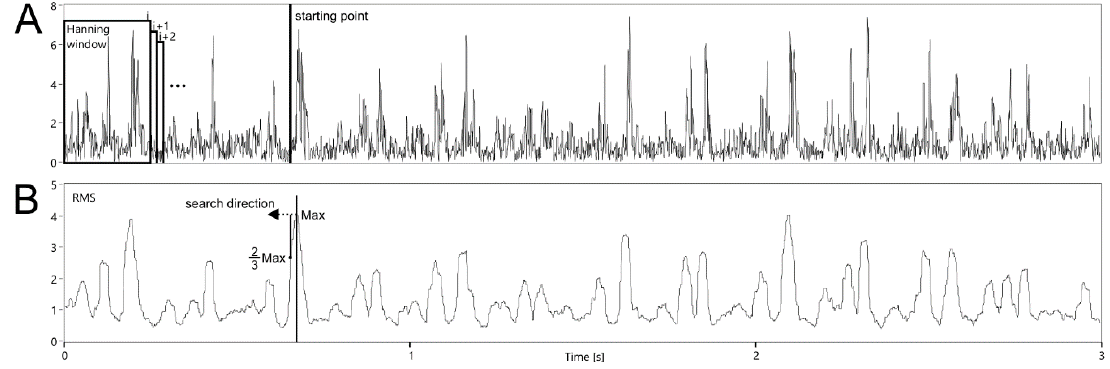
Figure 8. Idea of searching a starting point within the analysis of the envelope signal ( A ) for segmentation of instantaneous F j values using the D2 algorithm based on RMS function ( B ).